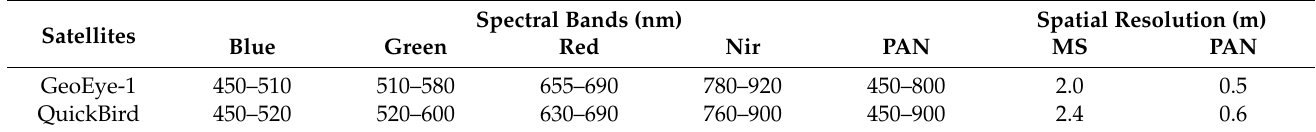
Table 2. Spectral bands and spatial resolution of GeoEye-1 and Quickbird